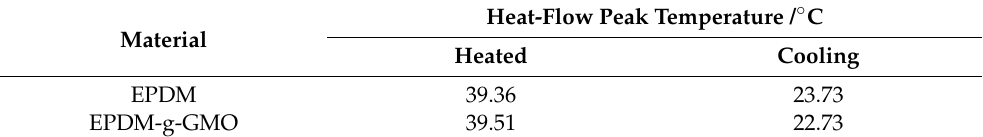
Figure 4. DSC temperature spectra of heat flow in heating ( left panel ) and cooling ( right panel ) processes for the crosslinked EPDM and EPDM-g-GMO materials. Table 3. Thermal parameters of glassy–elastomeric phase transitions from DSC